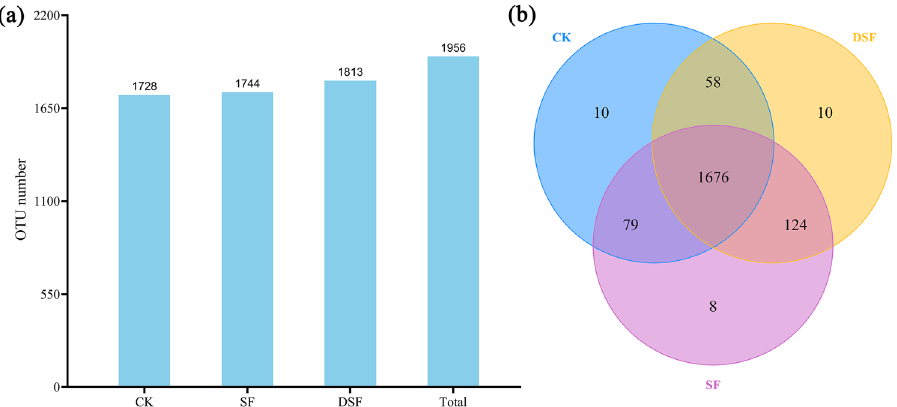
Figure 2. ( a ) The number of OTUs in different treatments. ( b ) The Venn map for the characteristic number of rice rhizosphere microorganisms under different fertilization modes of slow-release fertilizer. Values are the mean of three replicates.